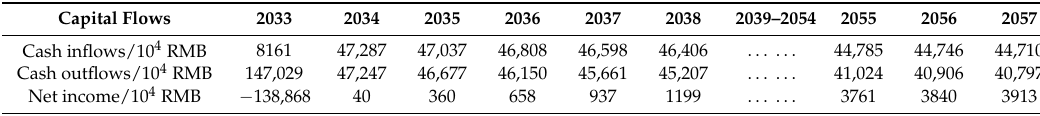
Table 6. The cash flow statement of the commercial operation